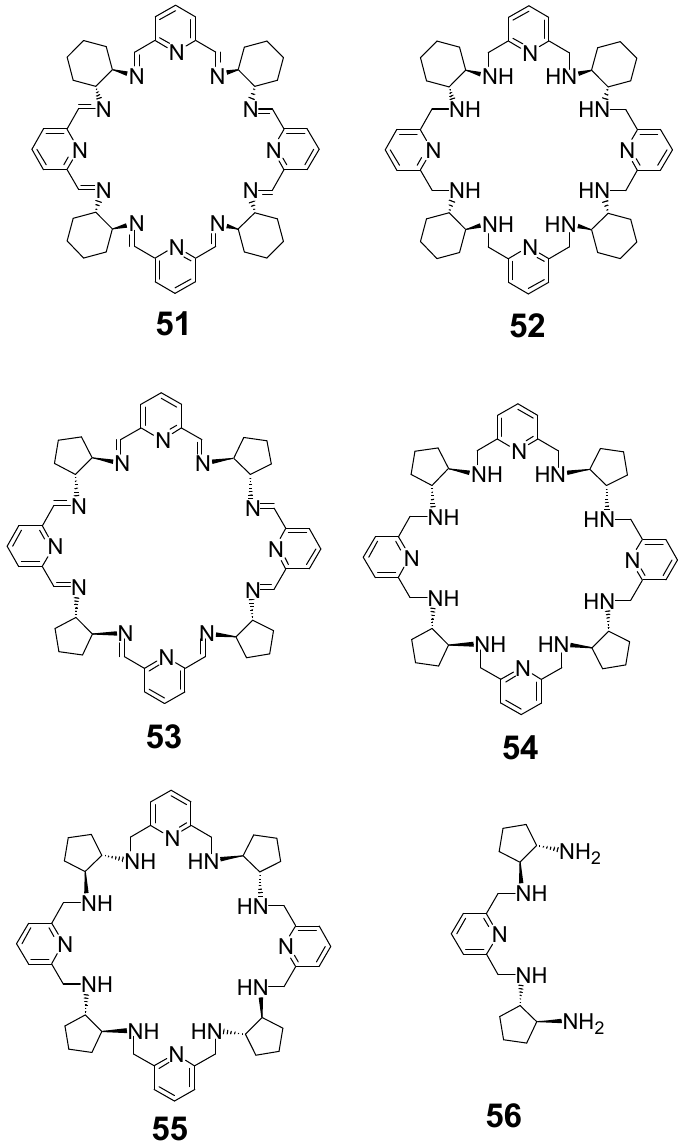
Figure 22. [4 + 4] macrocycles derived from DFP.